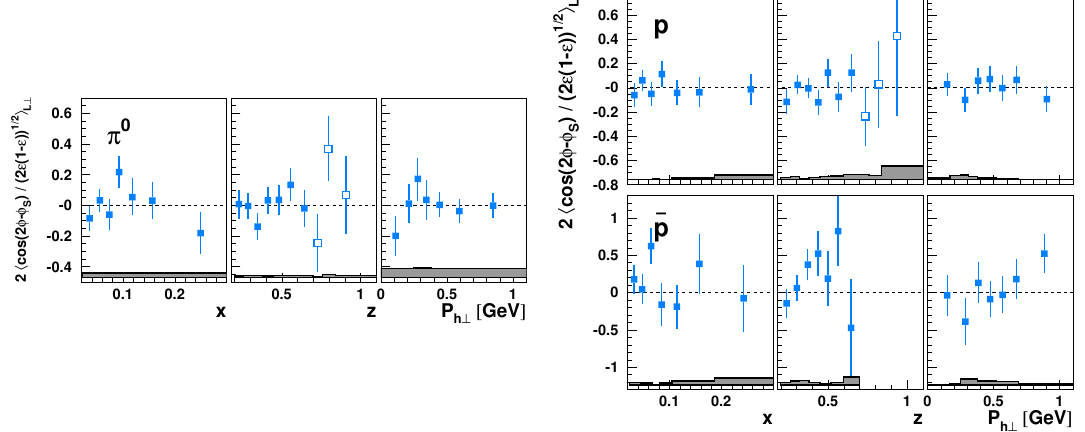
p Figure 30 . The 2 h cos(2 φ − φ S ) / 2 (cid:15) (1 − (cid:15) ) i h amplitudes for π 0 (left), protons, and antiprotons L ⊥ (right) presented either in bins of x , z , or P h ⊥ . Data at large values of z , marked by open points in the z projection, are not included in the other projections (no such high- z points are available for an- tiprotons due to a lack of precision). Systematic uncertainties are given as bands, not including the additional scale uncertainty of 8.0% due to the precision of the target-polarization